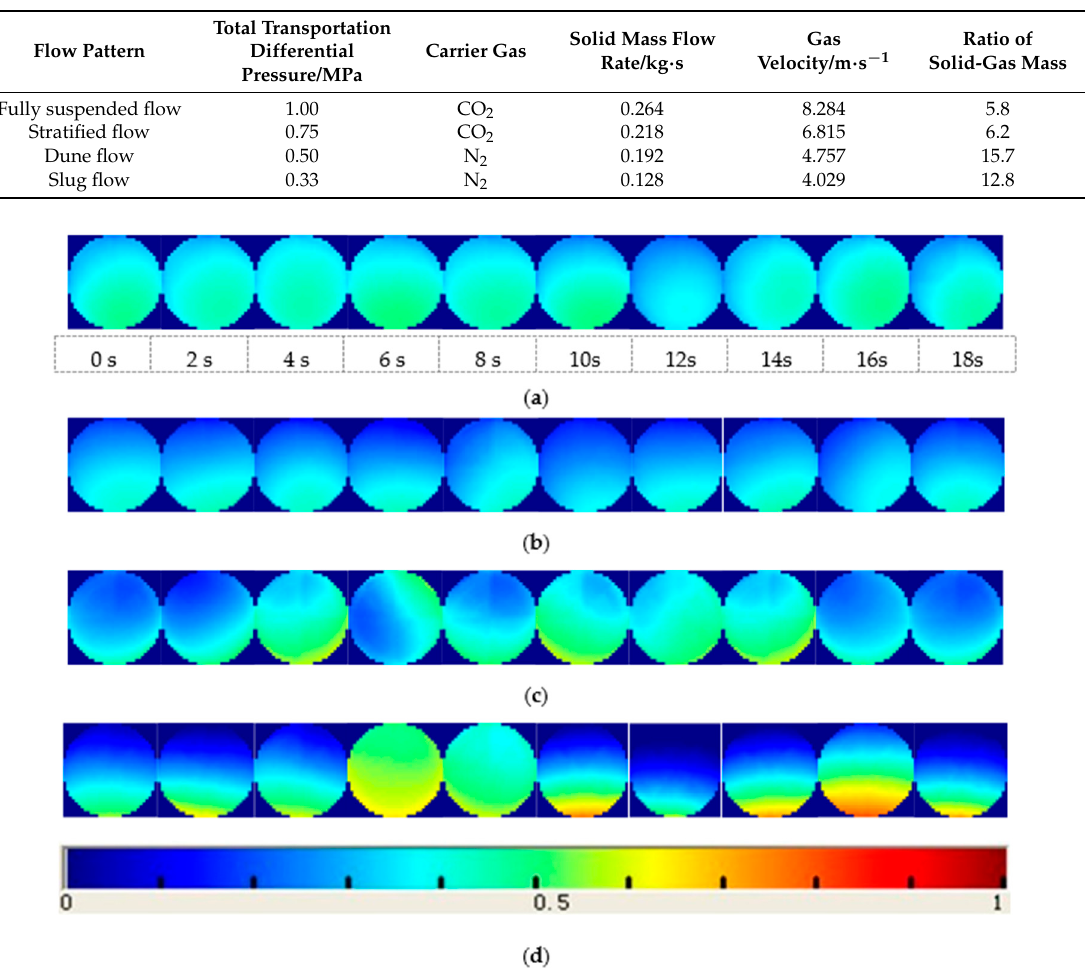
Table 2. Experimental operating conditions of the four flow patterns.